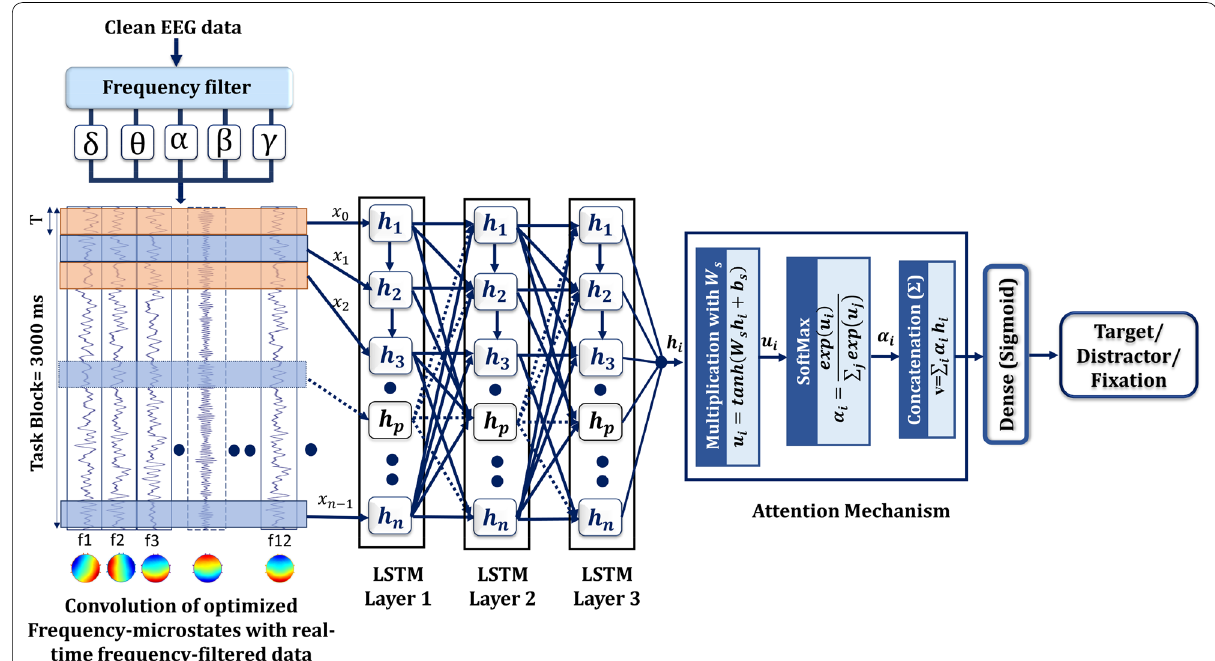
Fig. 3 Schematic diagram of Attention-based LSTM deep learning framework adopted in the study. ’T’ represents the temporal, sliding input sampling window size and is chosen between 180 to 750 ms/segment associated with the specific number of cells ranging from 4 to 16, based on the stability of transition probabilities of the optimized